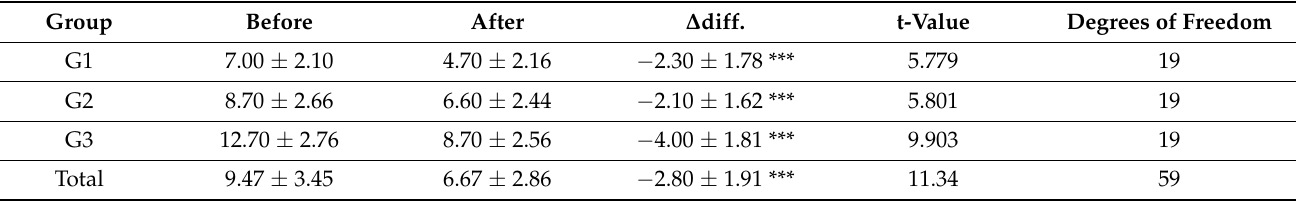
Table 5. Scoliometer readings in each group.